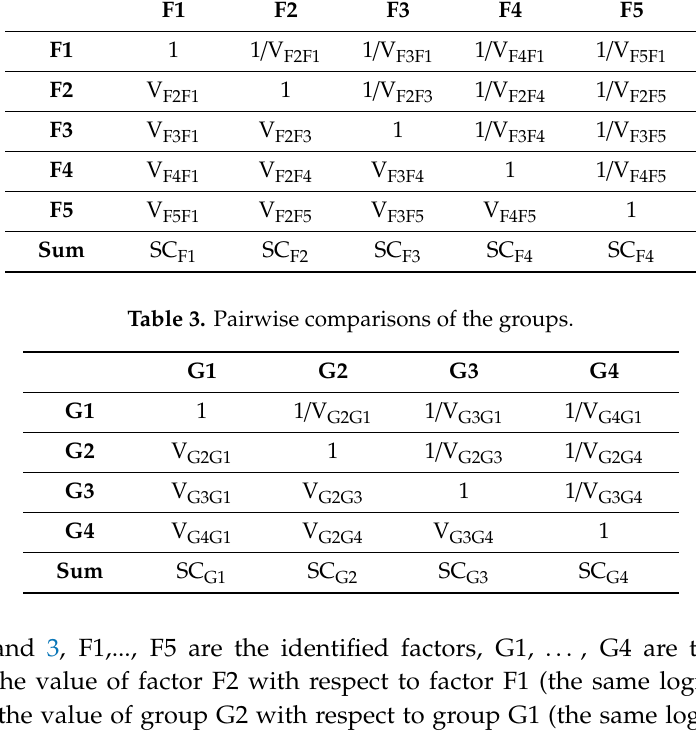
Figure 3. Word map of text-based analysis of the tourism industry. Source: author. Table 2. Pairwise comparisons per group.